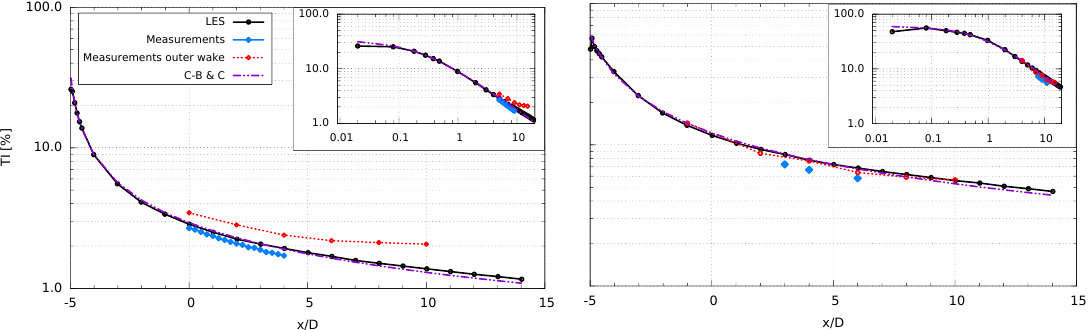
Figure 3. Comparison of the TI decay for the Ti3 ( left ) and Ti12 ( right ) cases without disk. C-B & C corresponds to Equation (5) as found in [41]. The inserted frames contain the same data but with a logarithmic scale also in both axes and denoting the distance from the inlet in x / D units.